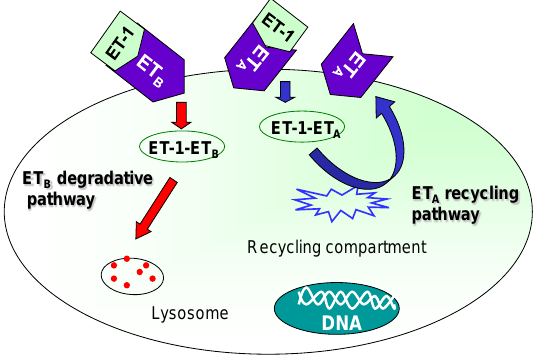
FIGURE 2. Schematic diagram of intracellular fates of ET A and ET B receptors. The ET A receptors are directed to the pericentriolar recycling compartment and reappear at the plasma membrane, whereas ET B receptors are directed to lysosomes for